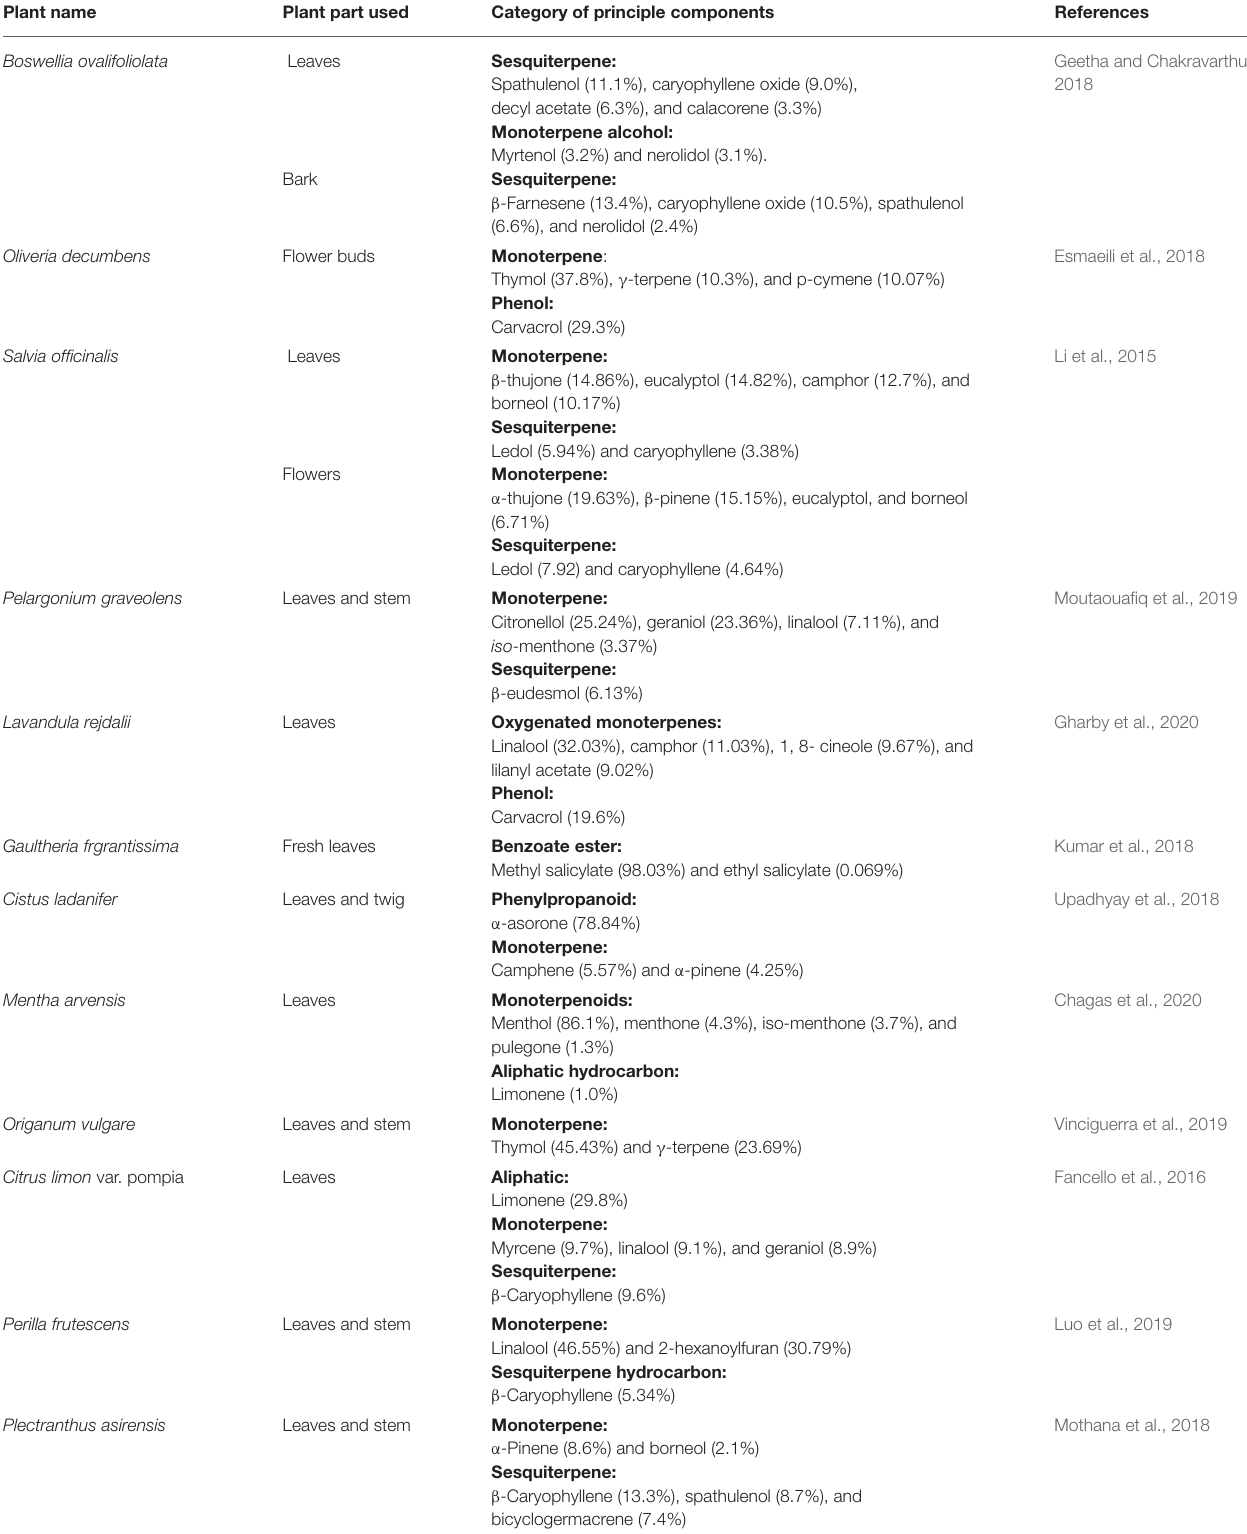
TABLE 1 | List of some common essential oils, their source with major components, and percent